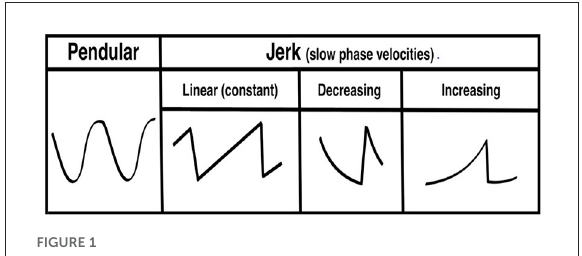
FIGURE1 Pendular and jerk nystagmus waveform morphologies.